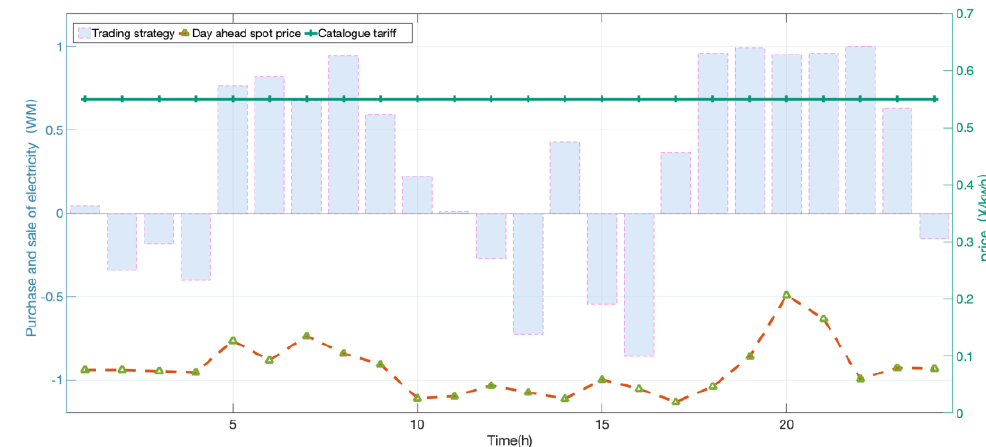
Figure 14. Opportunity bidding strategies of DERA considering psychological behavior.